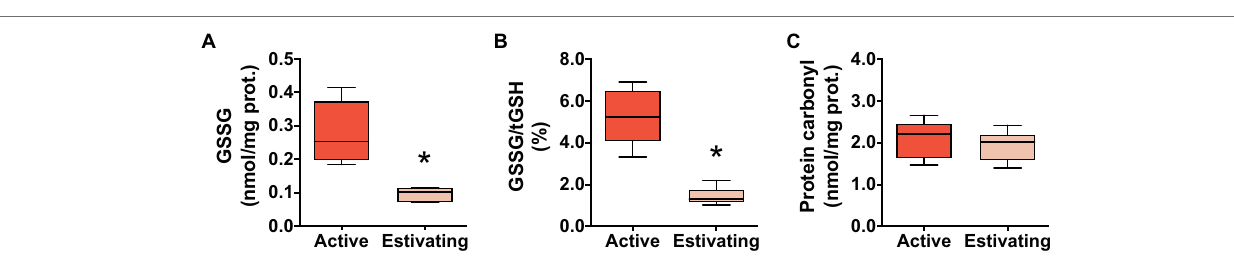
FIGURE 4 | Redox imbalance and oxidative stress markers in the skeletal muscle of Pleurodema diplolister collected during the dry season (estivating) or the rainy season (active). (A) Disulfide glutathione (GSSG). (B) Ratio between GSSG and total glutathione (GSSG/tGSH). (C) Protein carbonyl. The asterisk (*) denotes significant differences between active and estivating groups. N = 6.